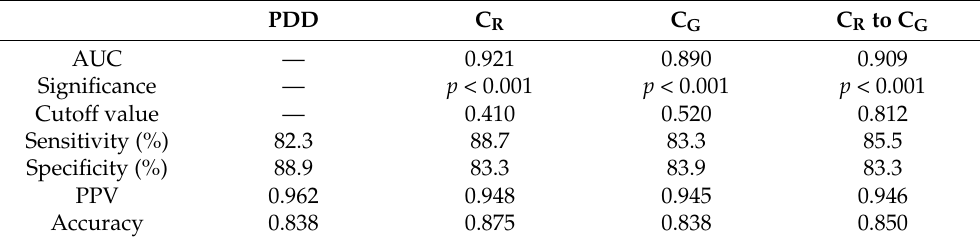
Table 3. Comparison between ALA-PDD and the combination of ALA-PDD and chromaticity analysis for discriminating between oral cancer or high-risk dysplasia and low-risk dysplasia or benign lesions. PDD C R C G C R to C G AUC